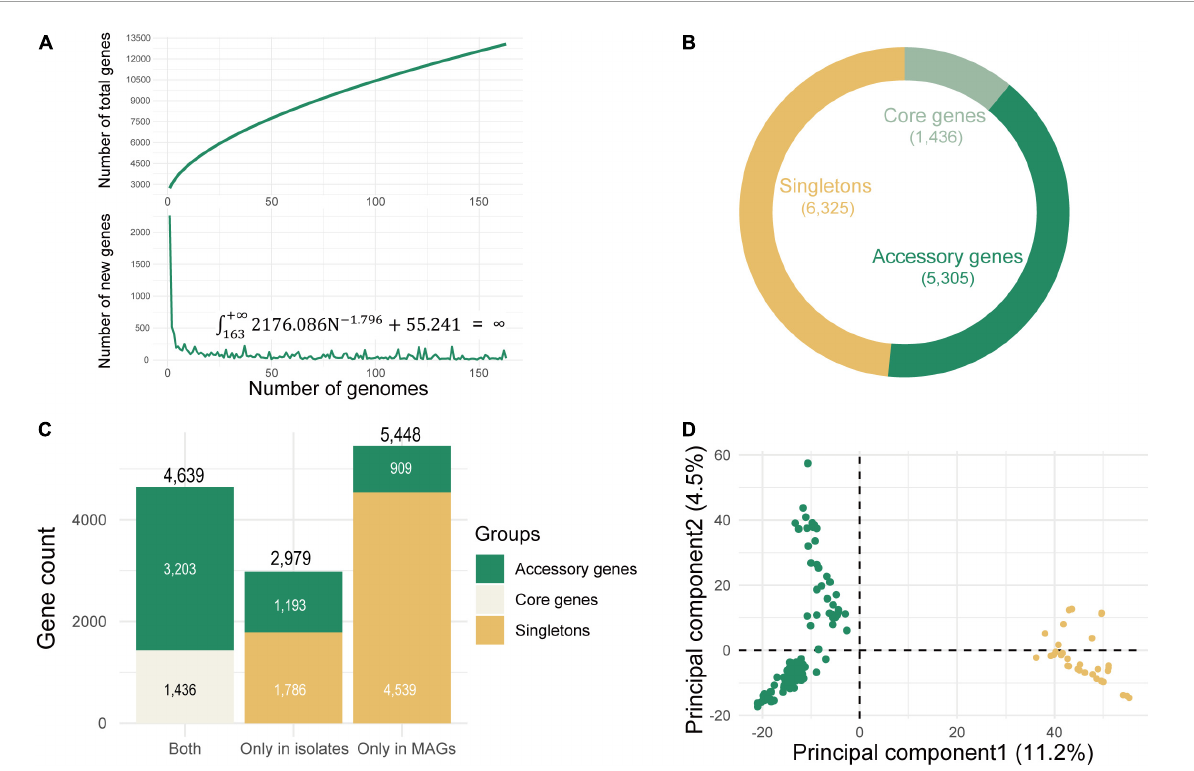
FIGURE5 Pangenome analysis of Lactococcus lactis using all 163 conspecific genomes. (A) Pangenome size estimation. The growth curve represents the number of total genes in the pangenome, and the decreasing curve represents the number of new genes. Estimating the size of new genes based on a power function ( n = kN r +a), where n represents the number of additional new genes detected for each additional genome sample, N represents the number of genome samples, and k, r and a are three parameters of this model. The points used for fitting are the mean of 10 random sampling. The fitting result is k = 2176.086 (2082.090, 2270.150); r = − 1.796 ( − 1.980, − 1.641); a = 55.241 (47.308, 63.108) (R 2 = 0.935), +∞ ∫ and the integral is infinite: 2176 . 086N − 1 . 796 + 55 . 241 = ∞ . The values in brackets are 95% confidence intervals. As for fitting of total number 163 of genes, the deduced mathematical function is y = 627.412x 0 . 561 +2105.194, R 2 = 0.998. With the increasing number of genomes, the size of the pangenome continues to grow and does not reach a plateau stage, indicating an open pangenome. (B) The number of core, accessory, and singleton genes in pangenome. (C) The number of genes unique to metagenome-assembled genomes (MAGs), unique to isolate genomes, and common in two groups. (D) Separation of the subspecies of L. lactis subsp. lactis and L. lactis subsp. cremoris based on accessory genes ( n = 5,305) detected in the Roary-generated open